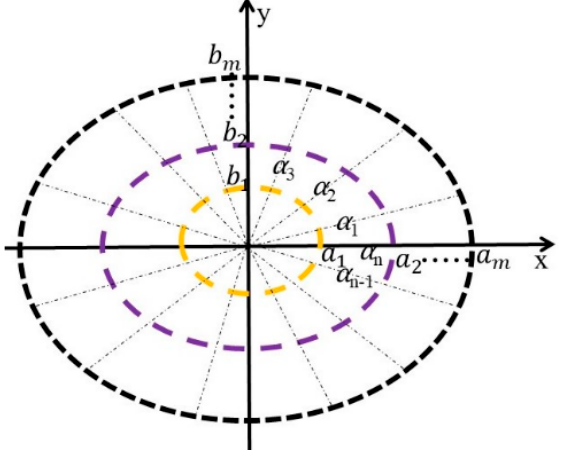
Figure 10. Division of the target plane for high beam.